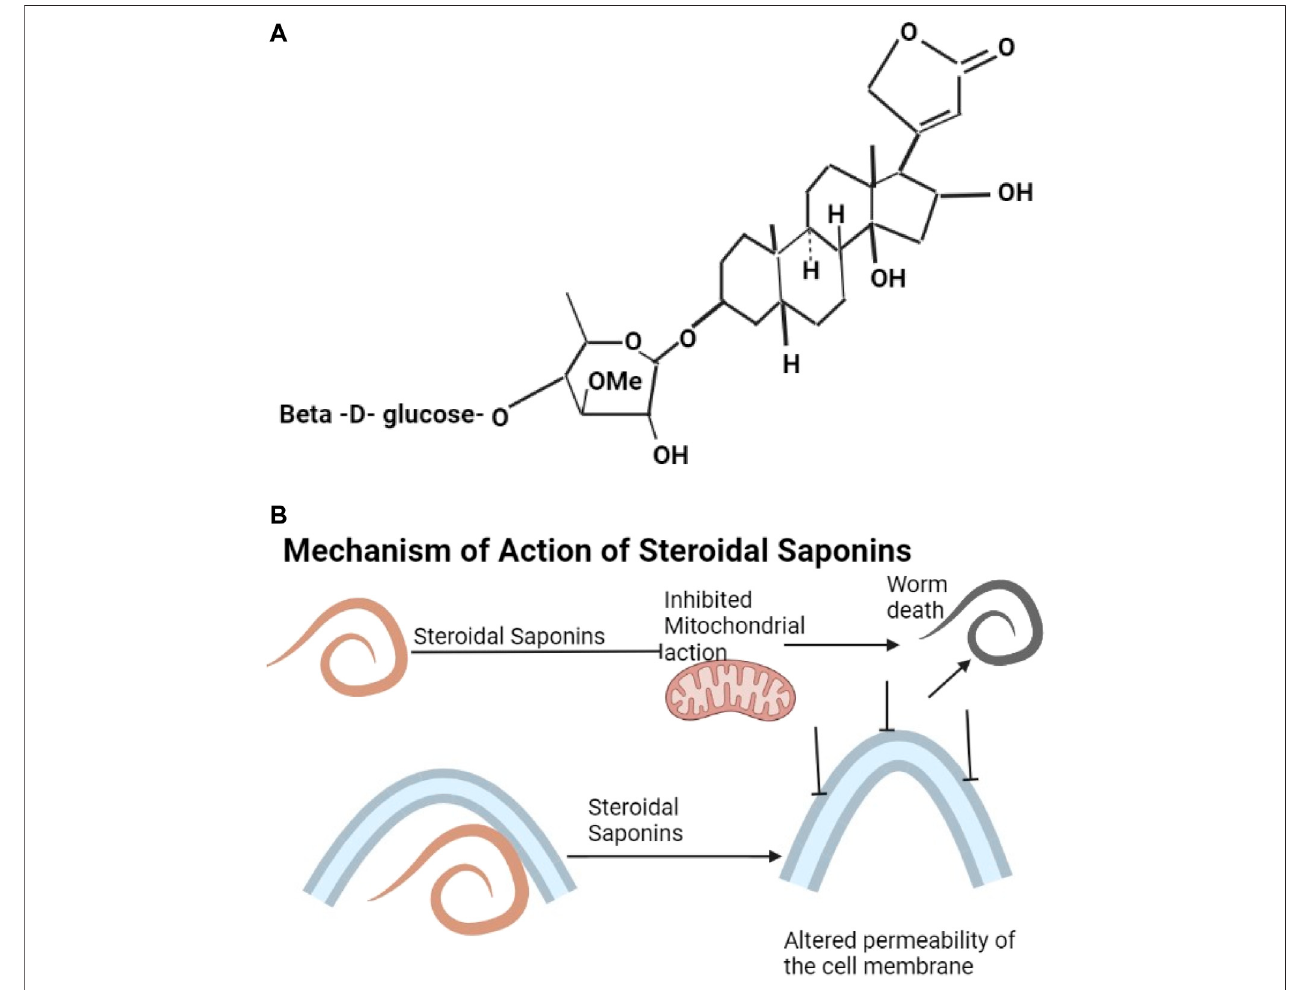
FIGURE3|(A) The structure ofdigitalin isanexampleofsteroidal saponins (Morgan and Wilson,1999). (B) Saponinsaffect mitochondrial action and also alter the permeability of the cell membrane leading to death of the helminth.